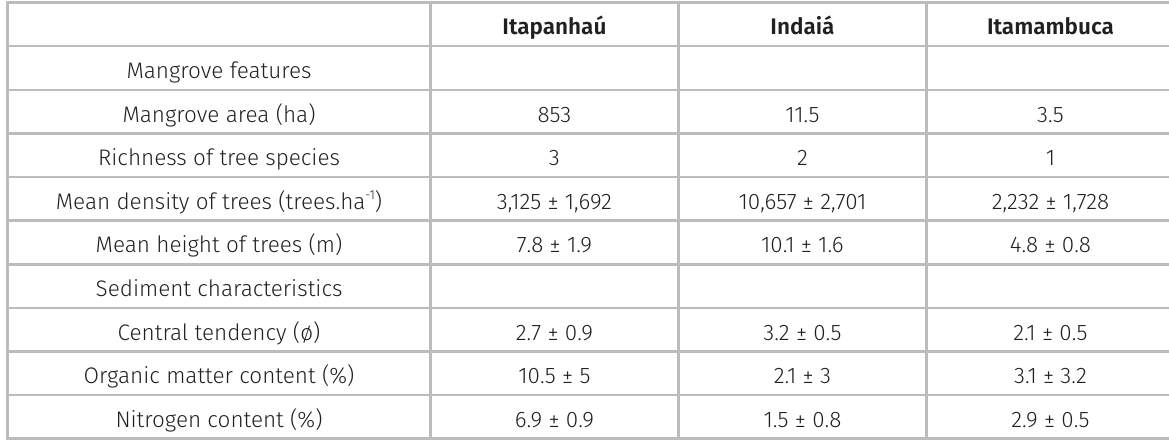
Table I. Environmental features of Itapanhaú, Indaiá, and Itamambuca mangroves, in which the populations of Minuca vocator were sampled, according to Colpo et al.